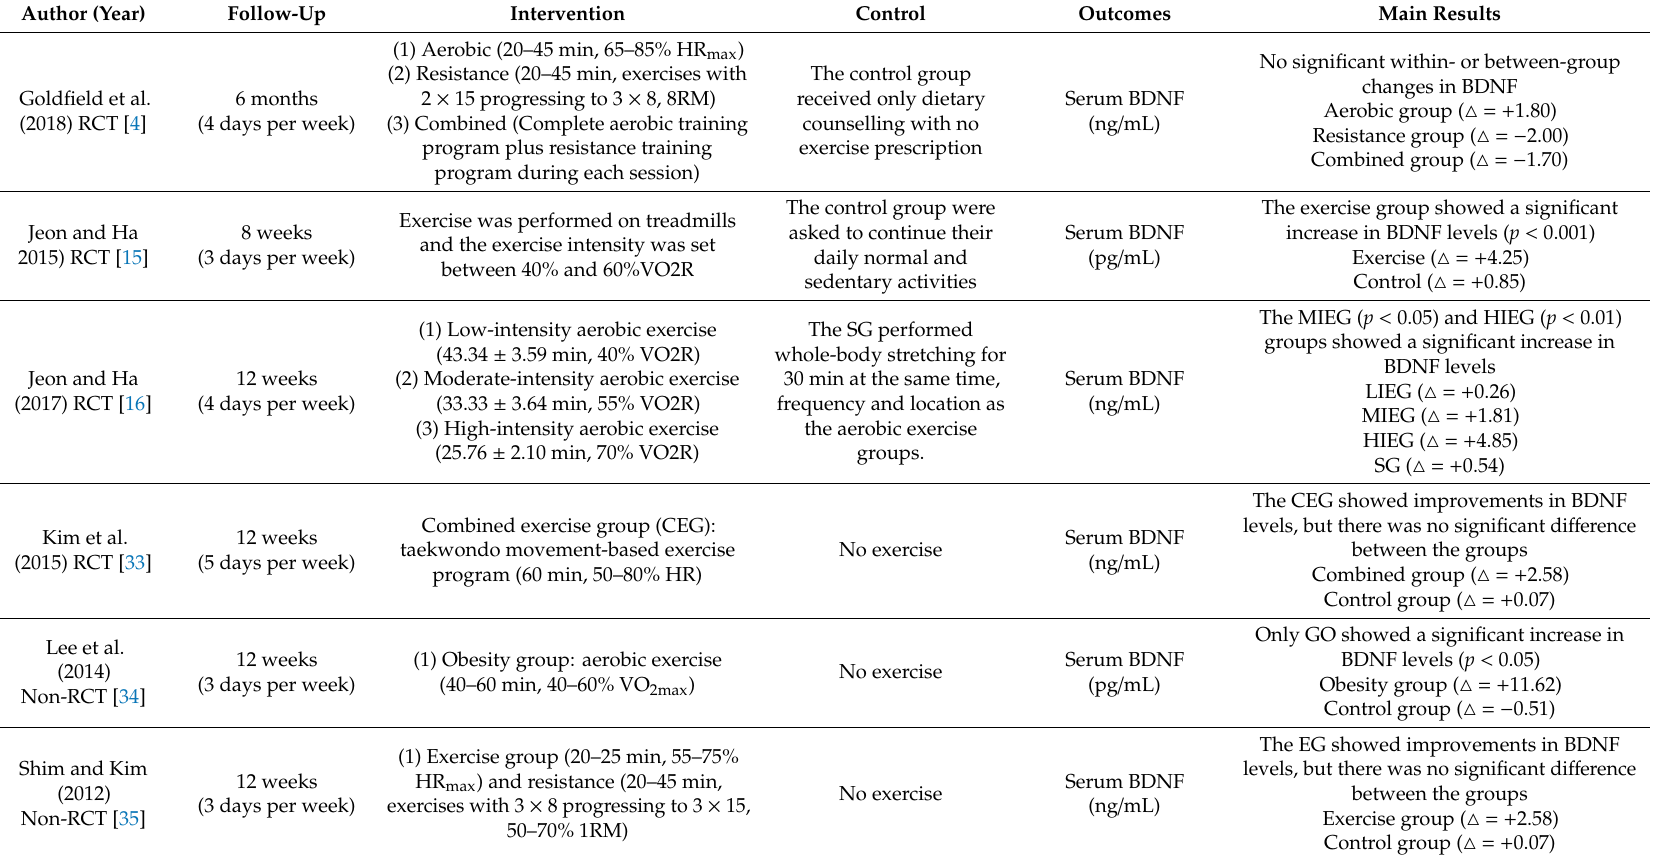
Table 2. Characteristics of the RCTs and non-RCTs included in the